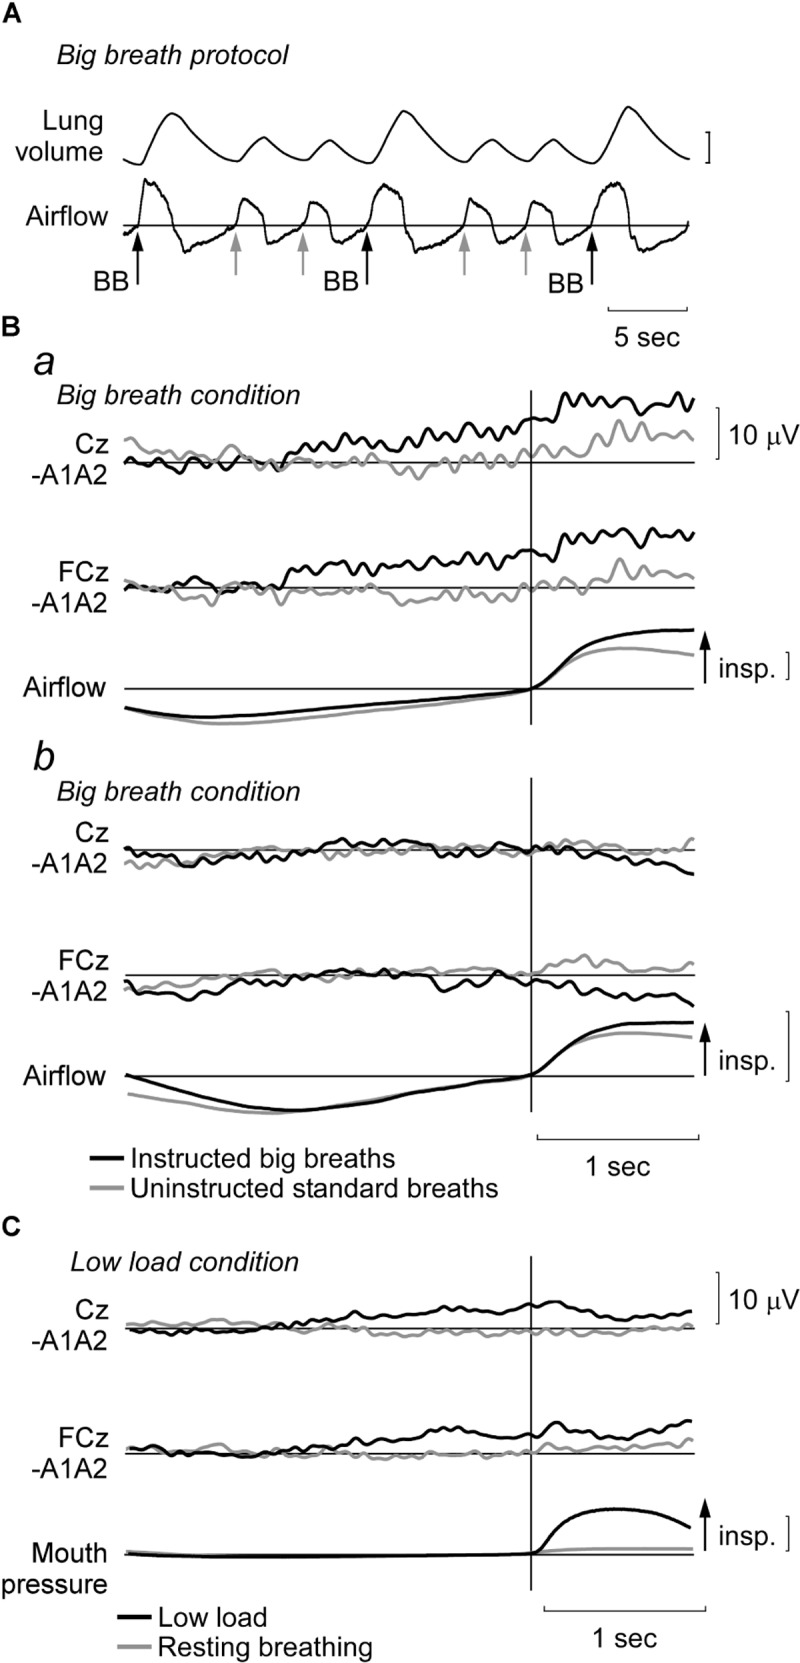
Representative recordings and EEG data during big breath and low load conditions. (A) In a trial of unloaded breathing, participants were randomly instructed to perform a ‘big breath,’ i.e., aim to double tidal volume. For analysis, waveform averages were made from EEG segments from these instructed big breaths (BB; black arrows) and the uninstructed standard breaths in these trials (gray arrows). Vertical lung volume calibration: 1 l. (B) Average EEG traces at Cz and FCz and airflow for two participants during the big breath condition. Typical signals are shown for a participant (Ba) with a premotor potential during the instructed big breaths (black traces), but no potential during the uninstructed standard breaths (gray traces). For a different participant (Bb), a premotor potential was not observed in either condition. Vertical airflow calibration: 0.5 l/s. (C) Average EEG traces (as above) and mouth pressure during low inspiratory threshold load condition (black traces) and resting breathing (gray traces) for a participant in whom a premotor potential was detected in the low load condition. Vertical mouth pressure calibration: 10 cmH2O.